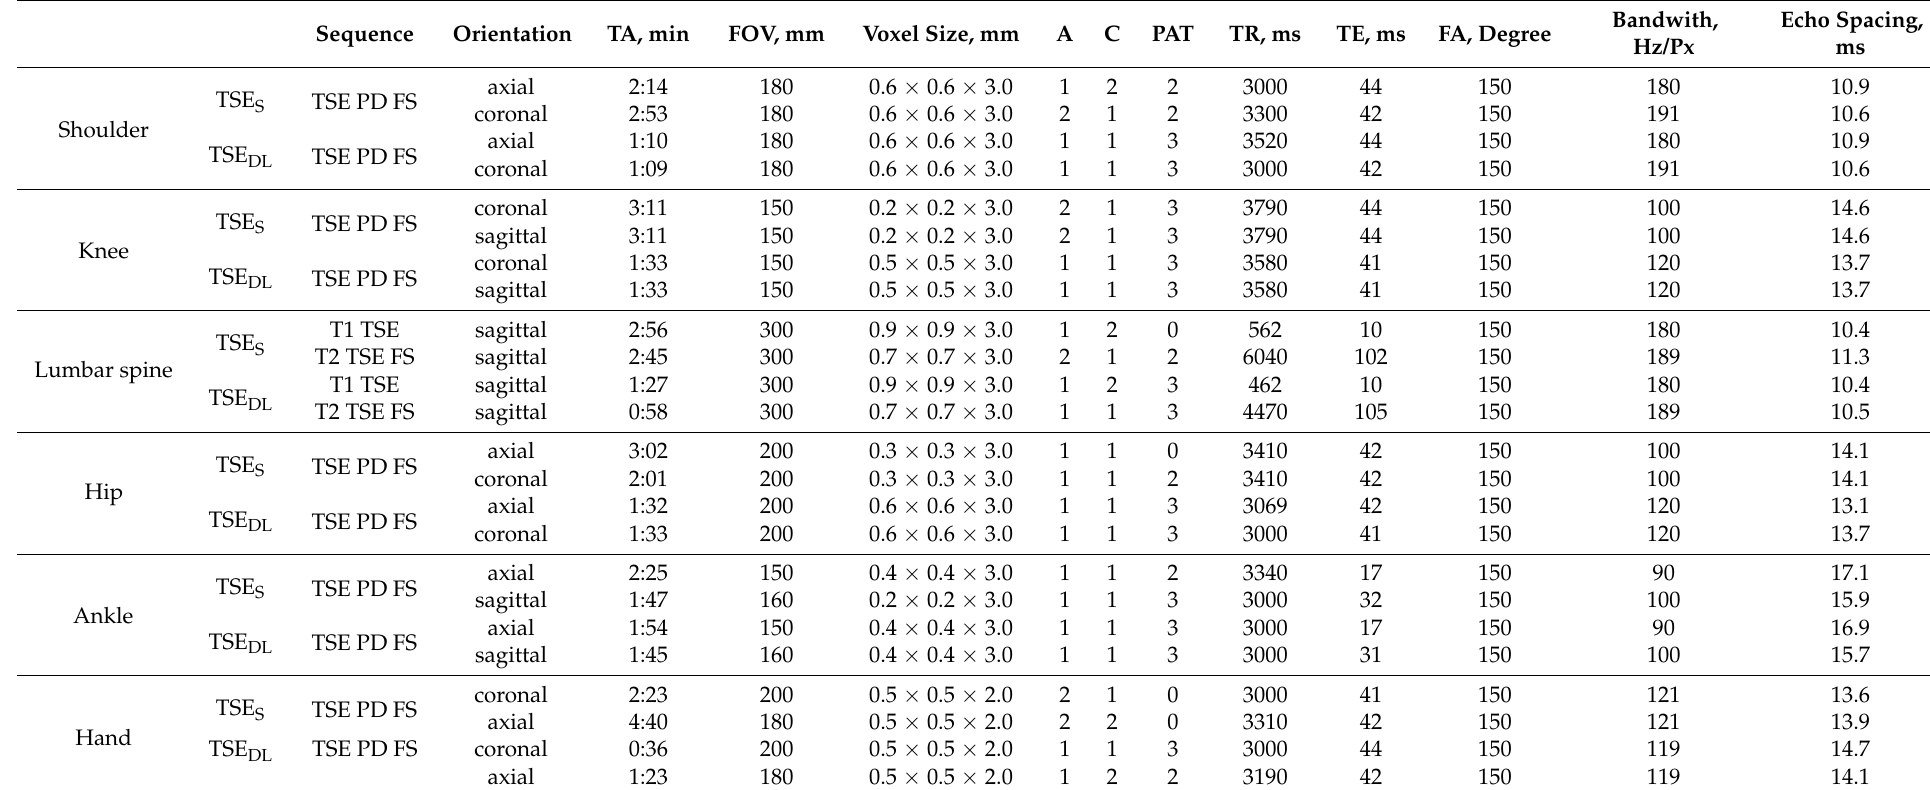
Table 1. Acquisition parameters of TSE S and TSE DL at 3